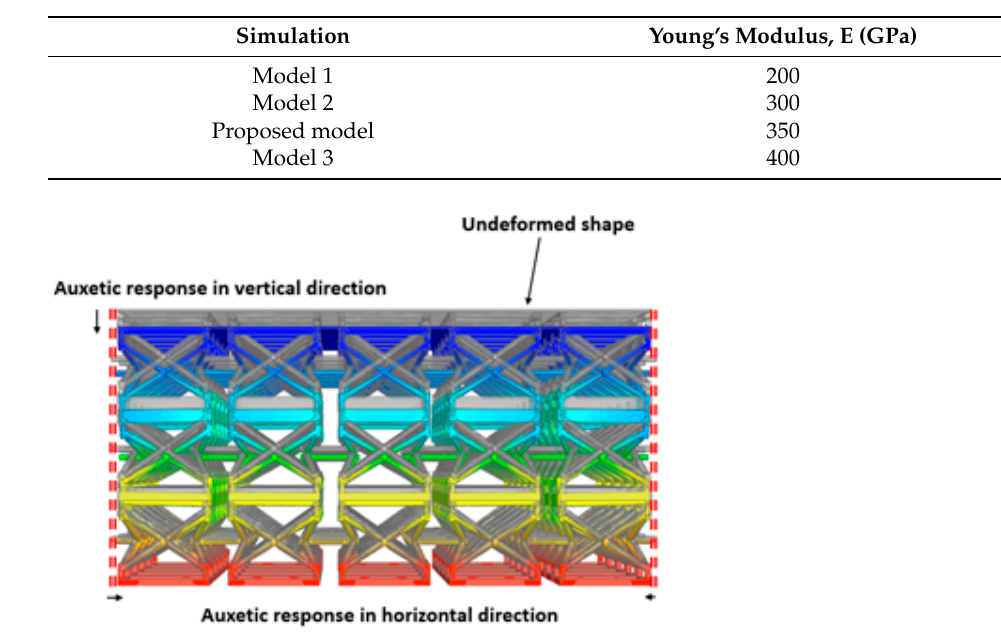
Table 3. The various Young’s moduli used in the MFA composite bridge bearing model.